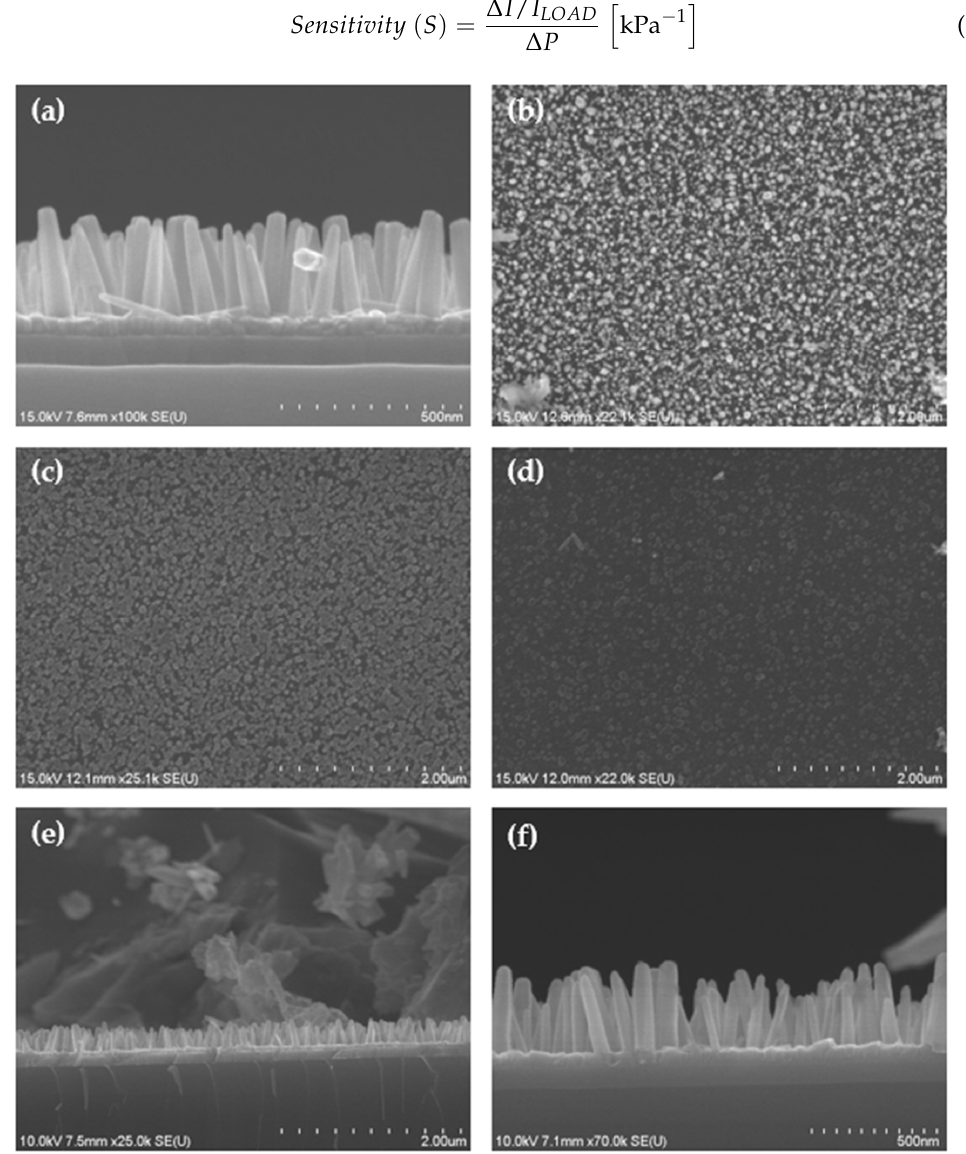
Figure 2. Nanorod SEM image of the fabricated device: ( a ) Cross section of NRs stacked: High density (0.05 M). Average diameter 60 nm and height 400 nm; ( b ) Top view of NRs stacked: High density (0.05 M); ( c ) Top view of NRs stacked: High density (0.050 M). By reducing the molarity, a change in density with decreasing diameter was expected, but there was no significant change in density with 0.05 M; ( d ) Top view of NRs stacked: Low density (0.05 M). During hydrothermal synthesis, the mesh pattern shadow mask was covered. By intentionally reducing the amount of source in contact with the seed layer, the density was reduced by interfering with nanorod growth; ( f ) SEM image of unbroken NRs after 450 g heavy weight durability